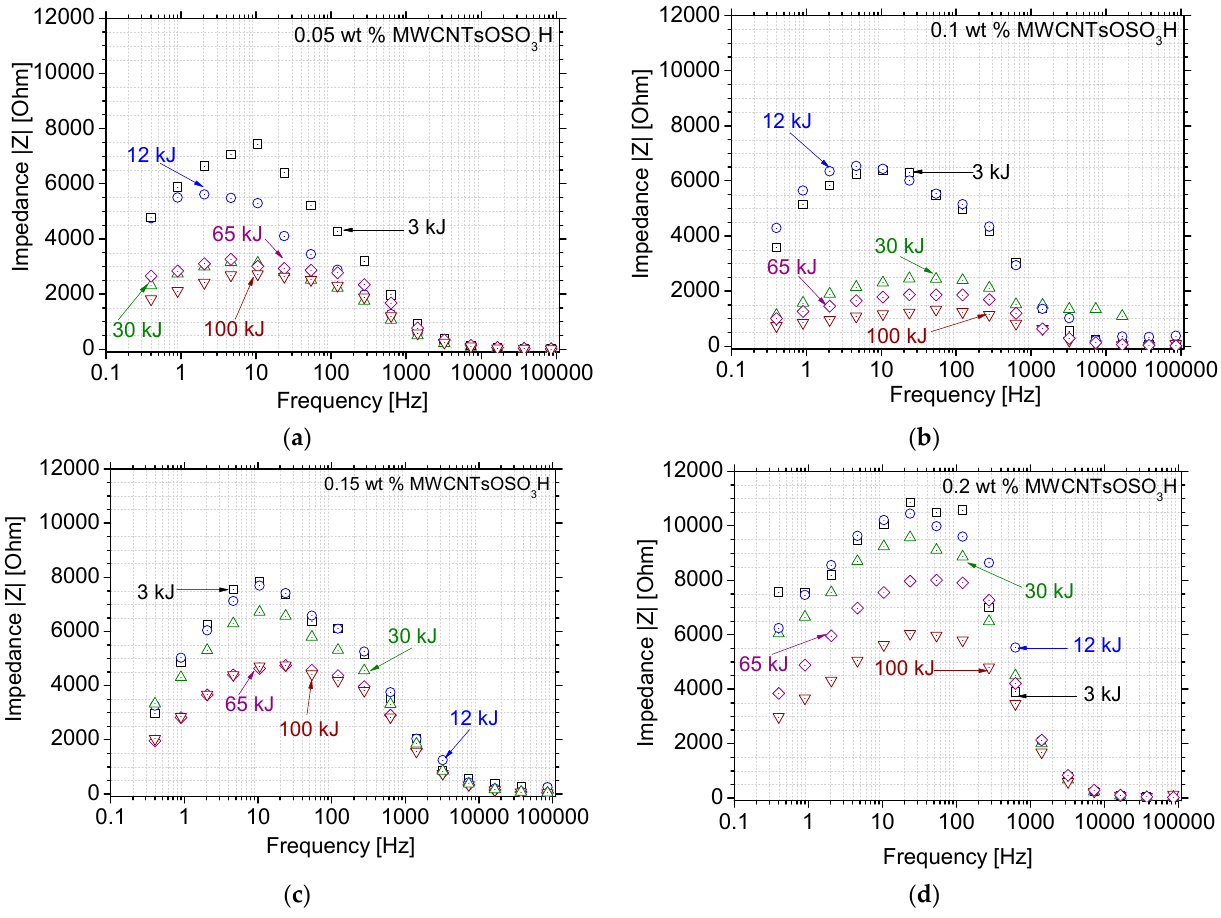
Figure 5. Bode plots of MWCNTsOSO 3 H aqueous dispersions at different ultrasonic energy levels and concentrations of ( a ) 0.05, ( b ) 0.10, ( c ) 0.15 and ( d ) 0.20 wt.%, respectively. The 0.10 wt.% dispersions display the lowest impedance modulus |Z| at high ultra- sonic energy values and higher frequencies. Due to polarization phenomena that may af- fect the measurements, the impedance values at very low frequencies (i.e., f < 100 Hz) were not taken into consideration. The highest concentration displays even higher impedance values in comparison to the lowest concentration, which can be attributed to the higher degree of agglomeration, which is inevitable due to the large quantity of nanoparticles present in the dispersion. Thus, the lowest impedance modulus is obtained for the 0.10 wt.% dispersion and 65 kJ ultrasonic energy. Slightly lower, but similar values are obtained for the 100-kJ ultra- sonic energy at the same concentration, but 65 kJ was chosen for the following reasons: (1) it would be more time-efficient and practical, (2) it allows for clearer comparison to the other nanostructures’ dispersions, for which a different concentration was found to be the optimal (0.15 wt.%). Although, the MWCNTsOSO 3 H dispersion was then produced at dif- ferent concentration, the ultrasonic energy amount was the same as in the other CBNs.